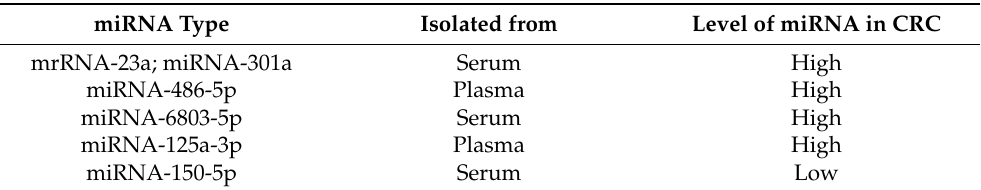
Table 2. Potential cancer diagnostic biomarkers miRNA in colorectal cancer. Adapted with permission from Ahmadi, M et al., 2021 [40].